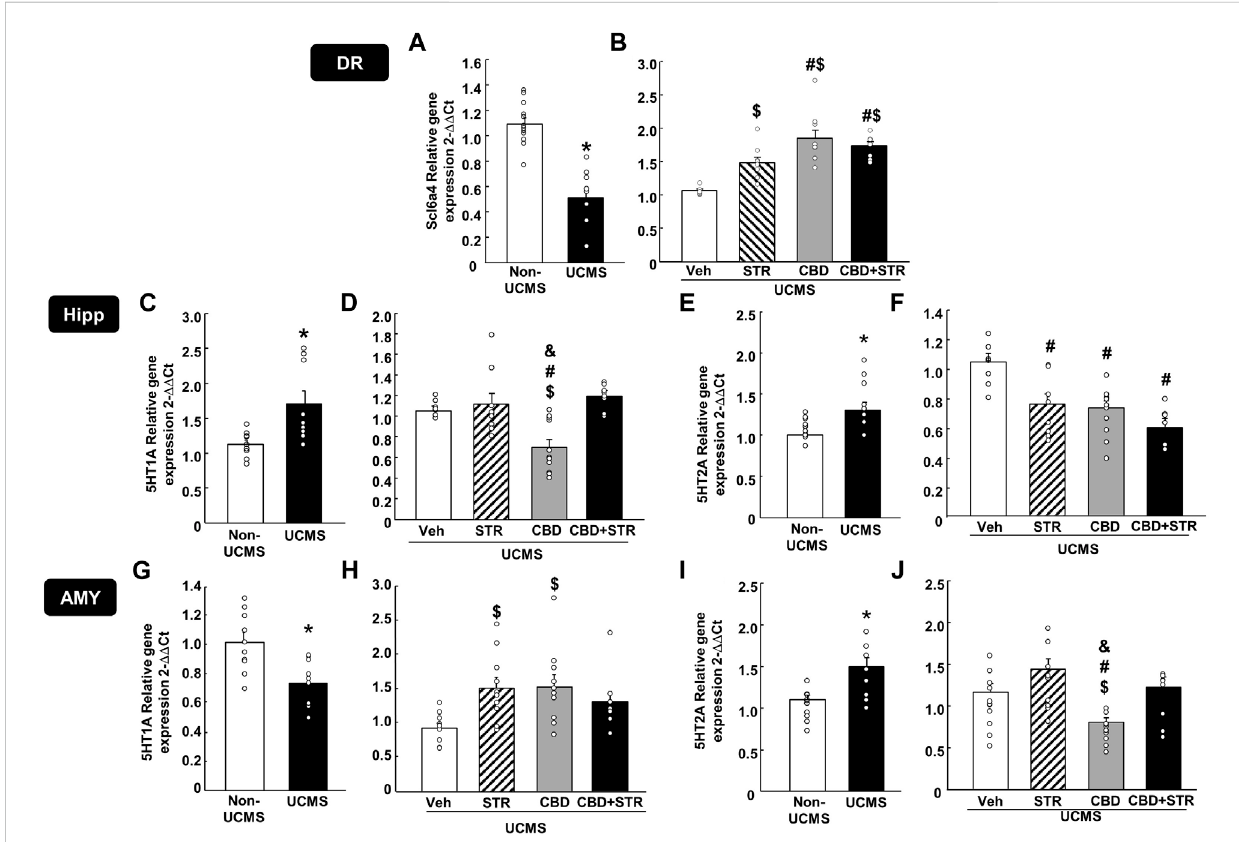
FIGURE 5 Relative gene expression of the serotonin transporter (Slc6a4) and receptors (5-HT1A and 5-HT2A) in the dorsal raphe (DR), DG of the hippocampus (DG) and AMY (amygdala) of mice exposed to the UCMS and treated with CBD, STR or their combination by real-time PCR . Columns represent the means and vertical lines the ±SEM of the Slc6a4 in the DR (panels A, B ), 5-HT1A and 5-HT2A in the Hipp (panels C – F , respectively) and the AMY (panels G – J , respectively). *Values from the VEH-treated UCMS group that differ signi fi cantly from VEH-treated non-UCMS group (Student ’ s t-test, p < 0.05).$ValuesfromSTR-,CBD-and/orCBD+STR-treatedUCMSmicethatweredifferentfromVEH-treatedUCMSmice.#ValuesfromCBD- and/or CBD + STR-treated UCMS mice that were different from STR-treated UCMS group, and Values from CBD-treated UCMS mice that were